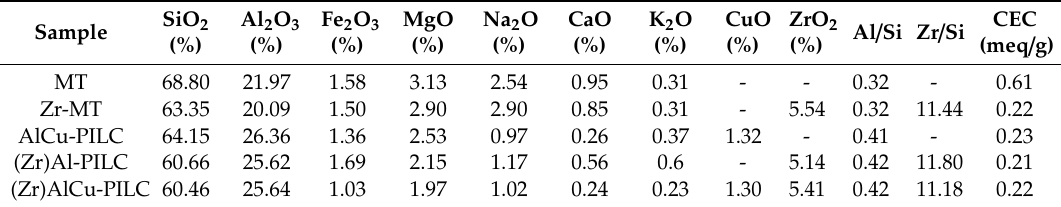
Table 2. Main chemical compositions of raw montmorillonite and its derived catalysts, obtained by EDS / EDAX (wt.%).